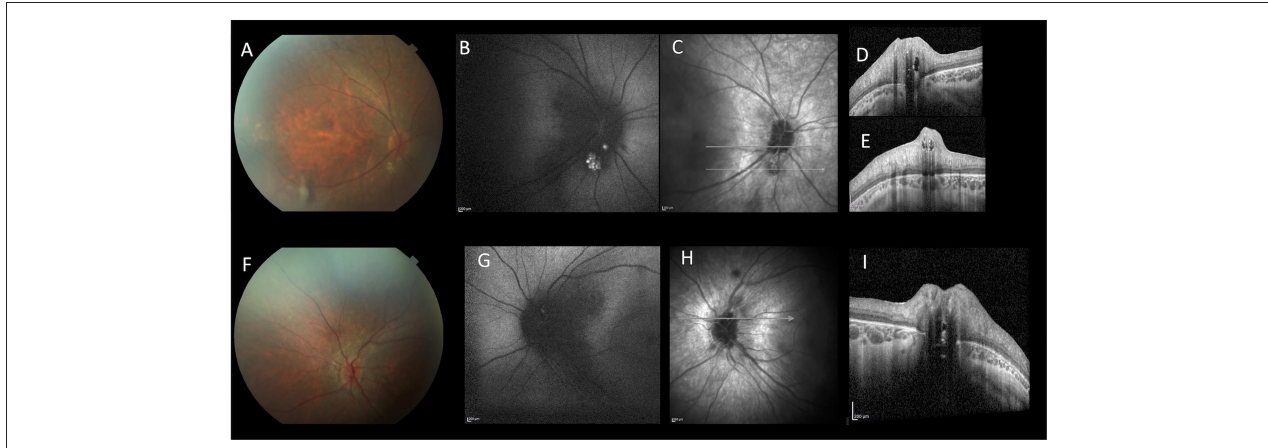
FIGURE 1 | Multimodal imaging of a 15-year-old patient affected by CDG-Ia. Color fundus photograph of the right (A) and left (F) . Blue-autofluorescence (FAF, B,G ) shows hyperautofluorescent spots. Linear SD-OCT (C–E,H,I) shows hyperreflective thickening of the retinal nerve fiber layer RNFL with internal moth-eaten optical empty spaces and posterior dense optical shadowing. These aspects are diagnostic for multiple, bilateral, calcific retinal astrocytic